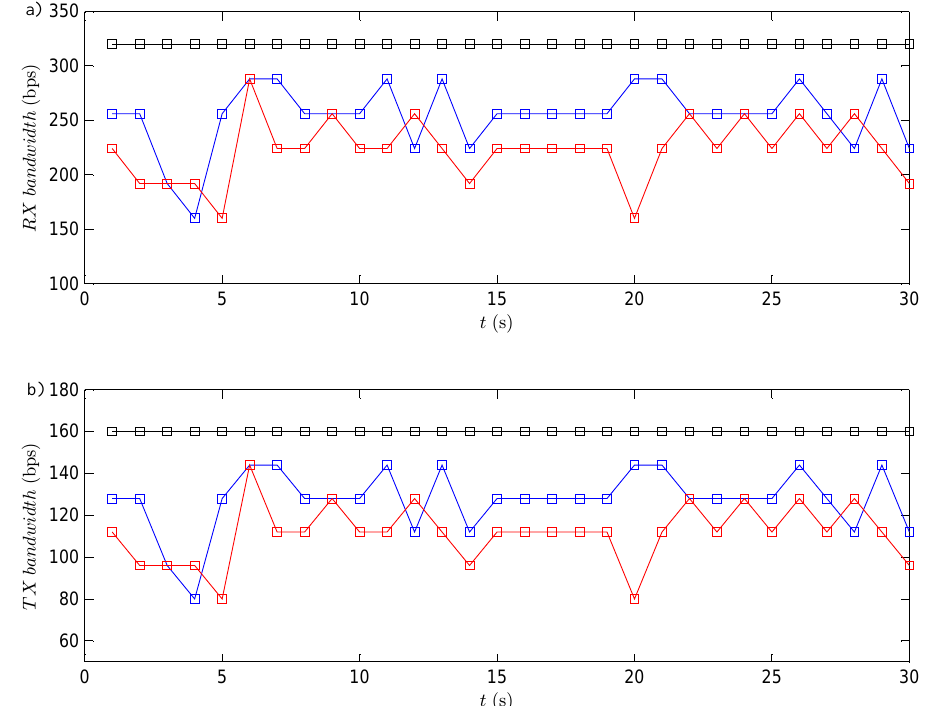
Figure 14. RF channel utilization. The black square is the discrete-time strategy; the blue square represents the event-based strategy with ¯ e = 10%; and and red dashed line is the event-based strategy with ¯ e = 15%. ( a ) Bandwidth used in reception (from the robots to the controller); ( b ) bandwidth used in transmission (from the controller to the robots).